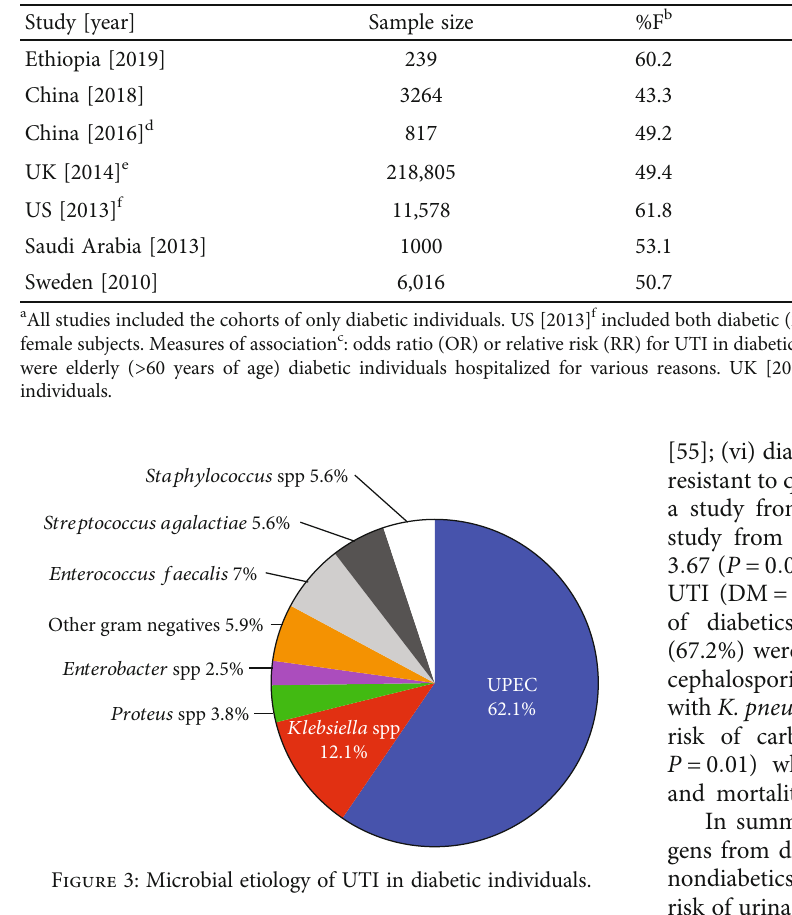
Table 5: Studies examining sex as a risk factor of UTI in diabetic individuals a .